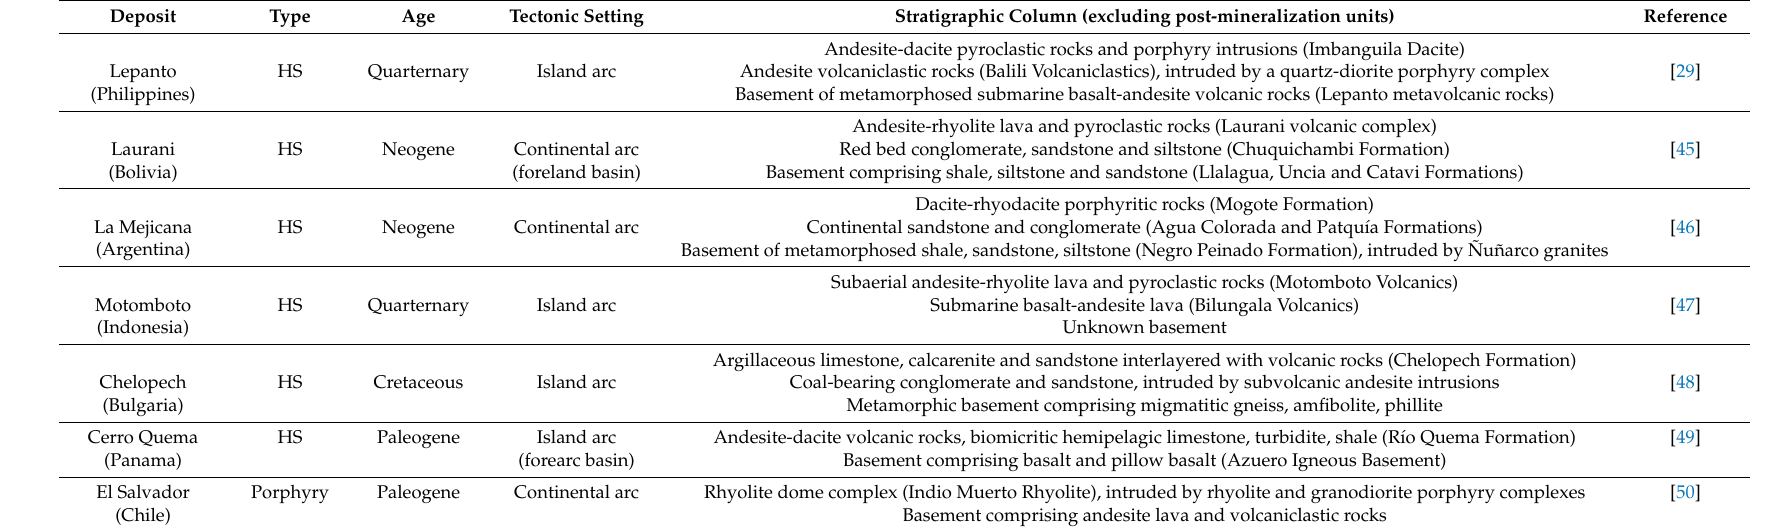
Table 2. List of deposits from which reference samples of enargite were